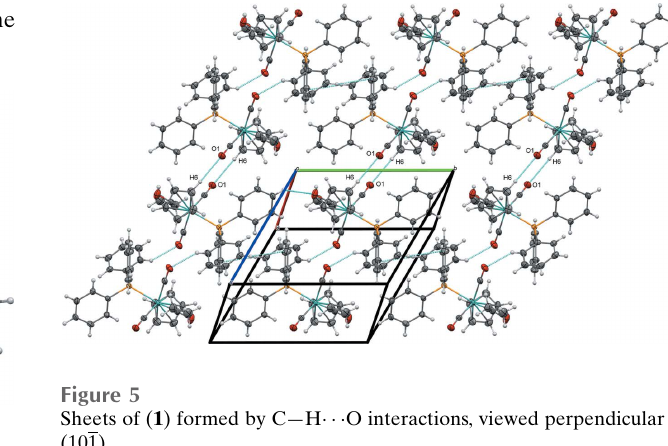
Figure 5 Sheets of ( 1 ) formed by C—H (cid:2)(cid:2)(cid:2) O interactions, viewed perpendicular to